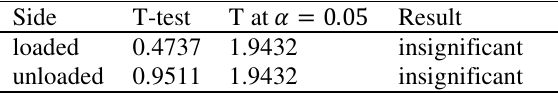
The Statistical Analysis by T-test Results of the Ultimate Deflection of Experimental Models and Numerical